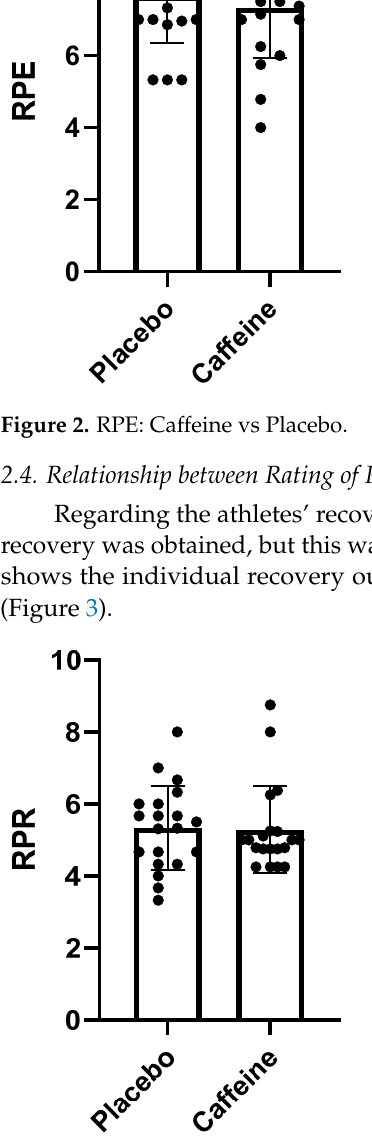
Figure 3. RPR: Caffeine vs. Placebo.